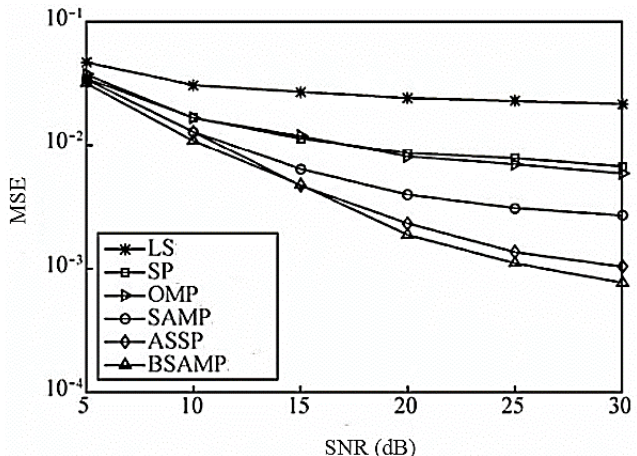
Figure 1. Comparison of mean square error of each algorithm under different signal to noise ratios